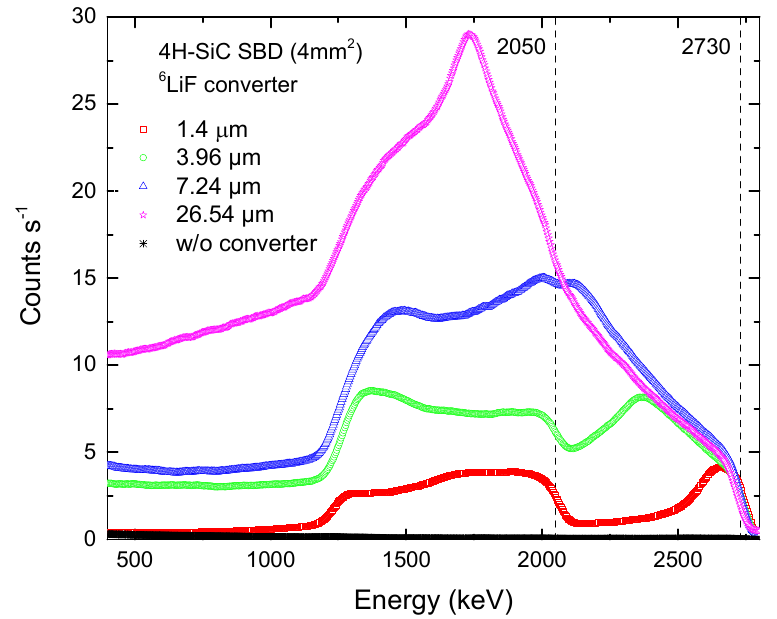
Figure 9. Radiation response of the 4H-SiC SBD equipped with 6 LiF thermal neutron converter layers with different thicknesses to the neutron field. Data adapted from Ref.